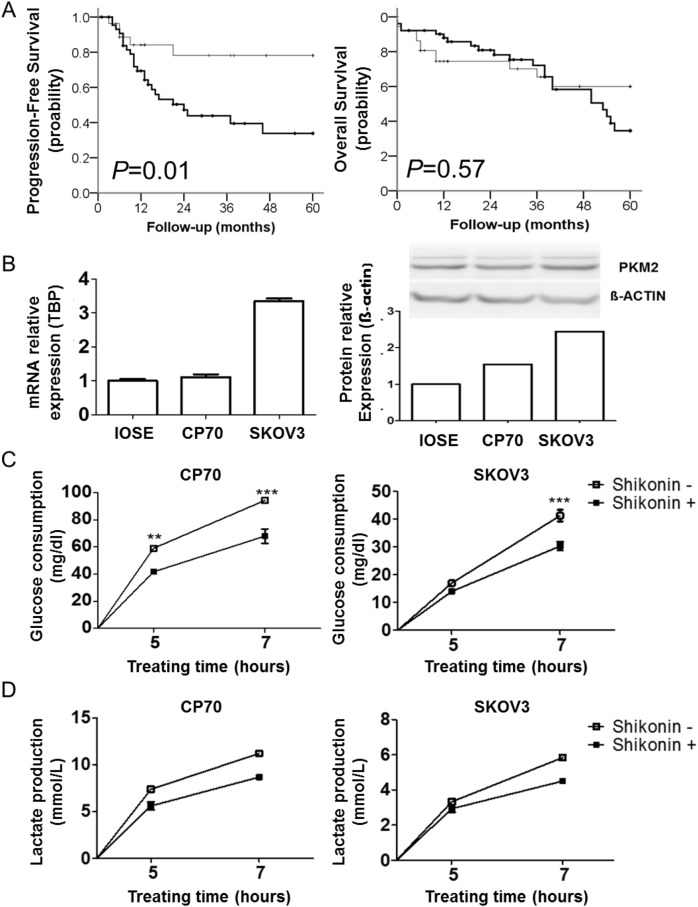
PKM2 expression decreases the survival of patients and PKM2 inhibition disrupts the glycolytic pathway in ovarian cancer cells.(A) Kaplan–Meier analysis of the probability of progression-free survival (p = 0.01) (left) and overall survival (p = 0.057) (right) in patients with ovarian cancer, stratified according to PKM2 expression (n = 88). (B) Expression of PKM2 in different ovarian cancer cell lines. (C and D) Time-dependent inhibition of glucose consumption (**p<0.01,***p<0.001) and lactate production in CP70 and SKOV3 cells following shikonin treatment. PKM2, Pyruvate kinase M2.